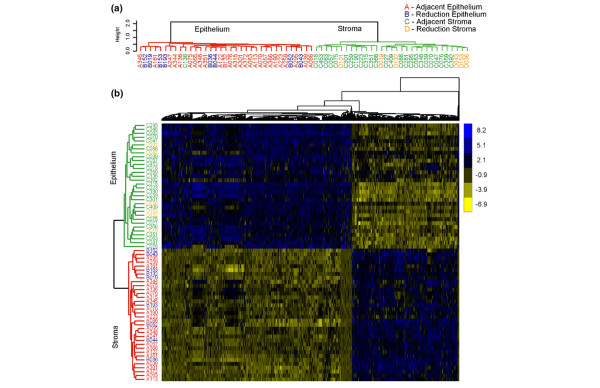
Hierarchical clustering and heatmap showing the segregation of samples by tissue type. (a) Hierarchical clustering of normal tissue samples shows segregation by tissue type (red, adjacent epithelium; blue, reduction epithelium; green, adjacent stroma; orange, reduction stroma). (b) Heatmap showing tissue specific gene expression clusters.